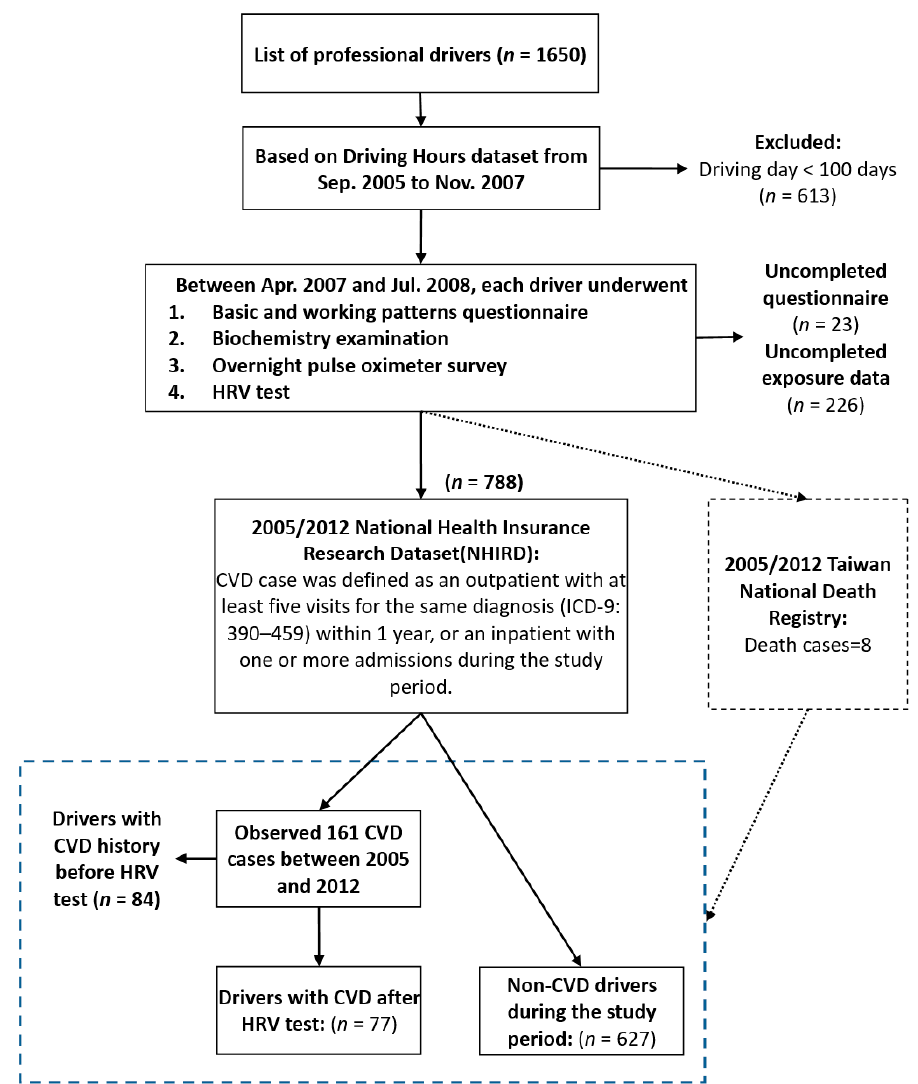
Figure 1. Study flow diagram in the Taiwan Bus Driver Cohort Study.